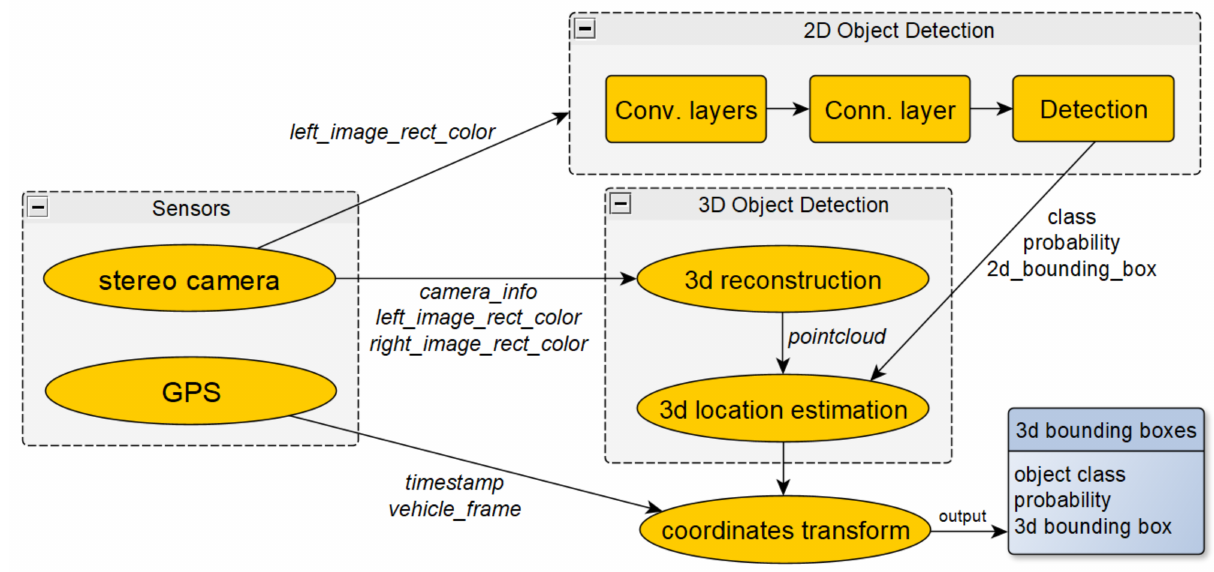
Figure 3. Data processing workflows within the edge